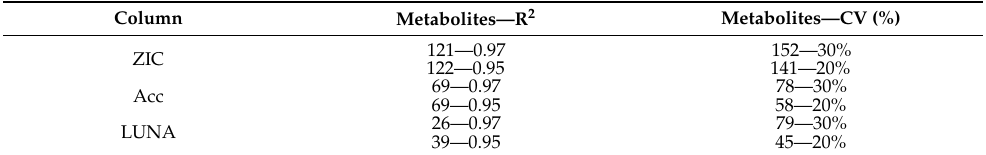
Table 5. Linearity and reproducibility for three HILIC columns. R squared (R 2 ) values per metabolite were calculated based on linearity of fit between measured relative change in pooled samples and corresponding dilution factor. Coefficient of variation (CV) per metabolite was calculated from re-injections of pooled samples. Indicated are number of metabolites which pass specified